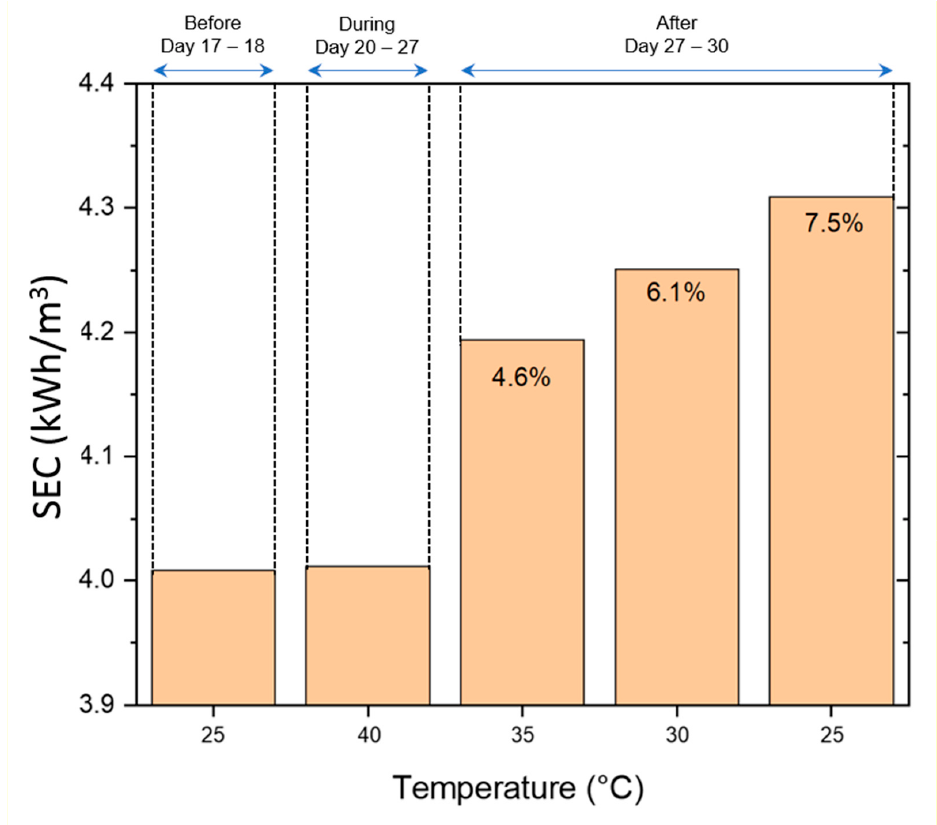
Figure 9. Average specific energy consumption (SEC) before, during, and after short-term (7-day) RO-feed seawater temperature increase. The change in SEC can also be correlated with the change in NPF, as discussed in Figure 6.